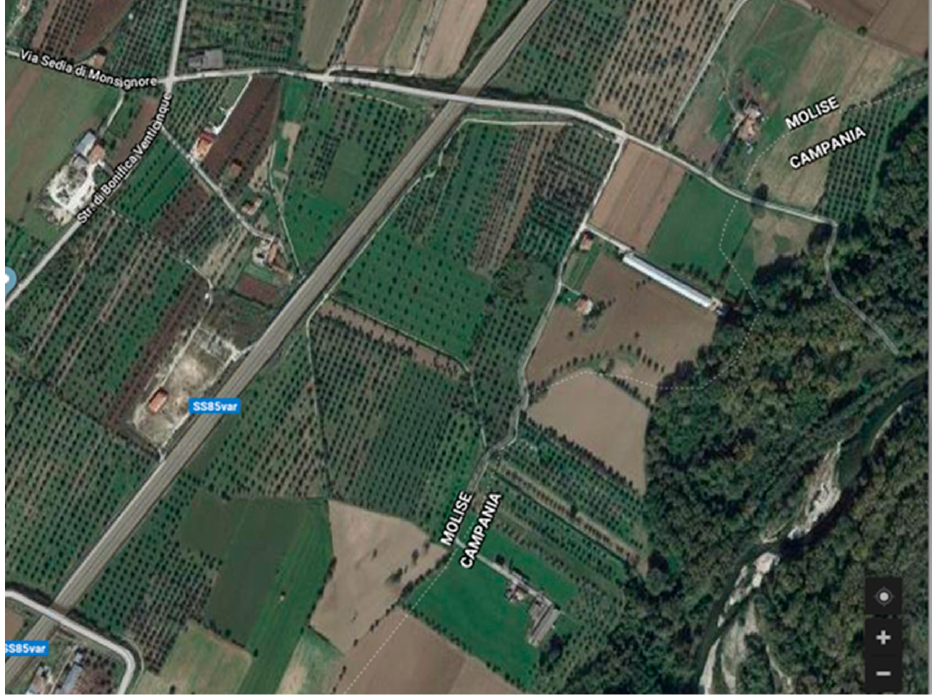
Figure 2. Aerial photo of the field.